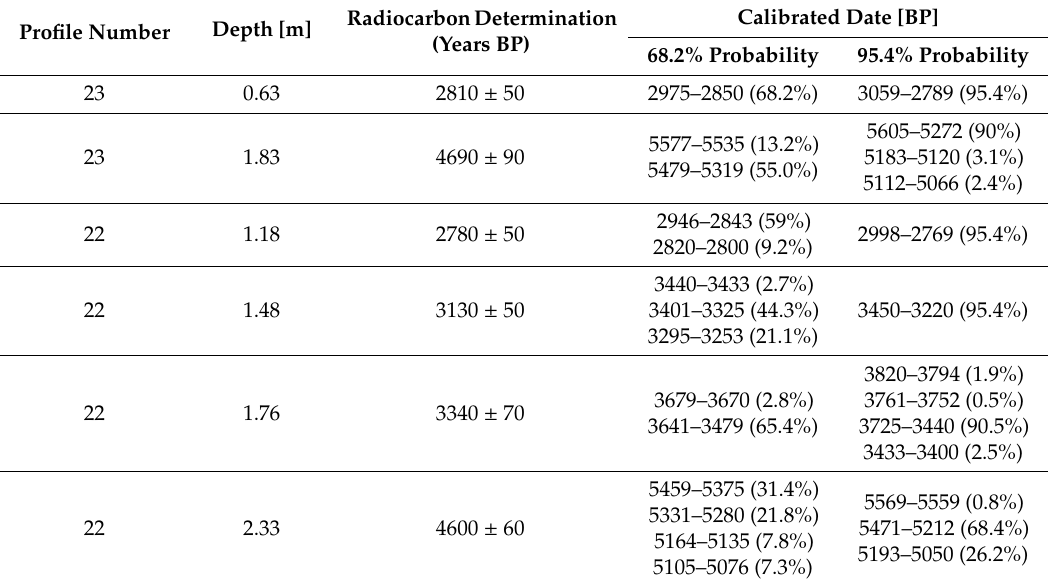
Table 3. Radiocarbon determinations and dates calibrated with IntCal13 curve.